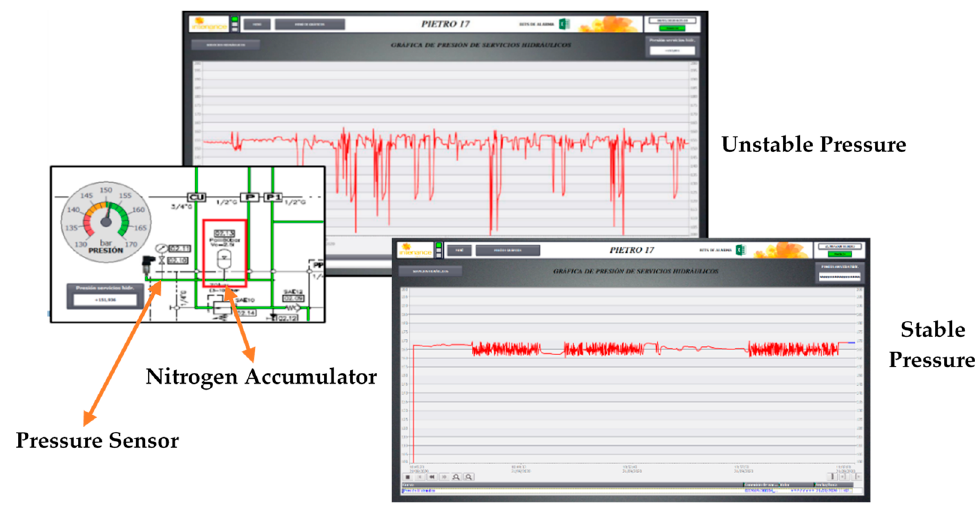
Figure 8. Hydraulic circuit and unstable and stable recorded pressure data.